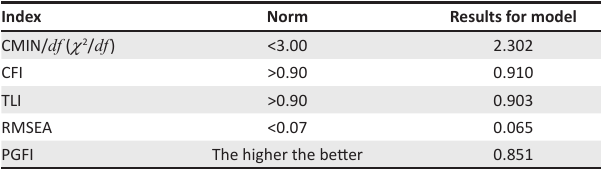
TABLE 4: Goodness-of-fit indices.